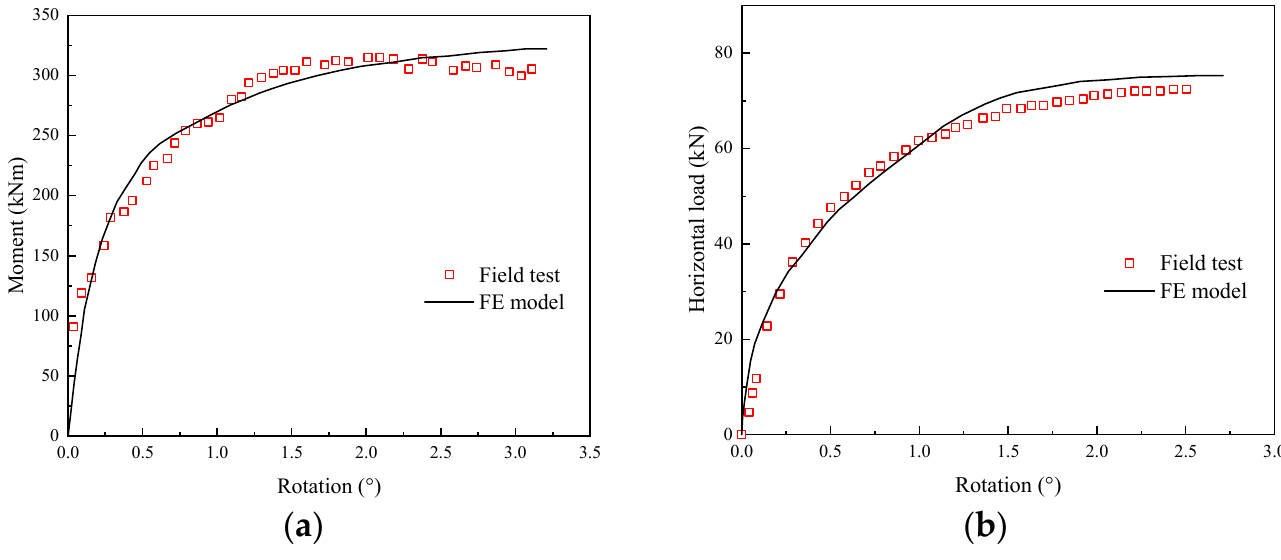
Figure 12. Comparison of measured and computed overturning response of filed test: ( a ) Frederik- shaven, ( b ) Sandy Haven.